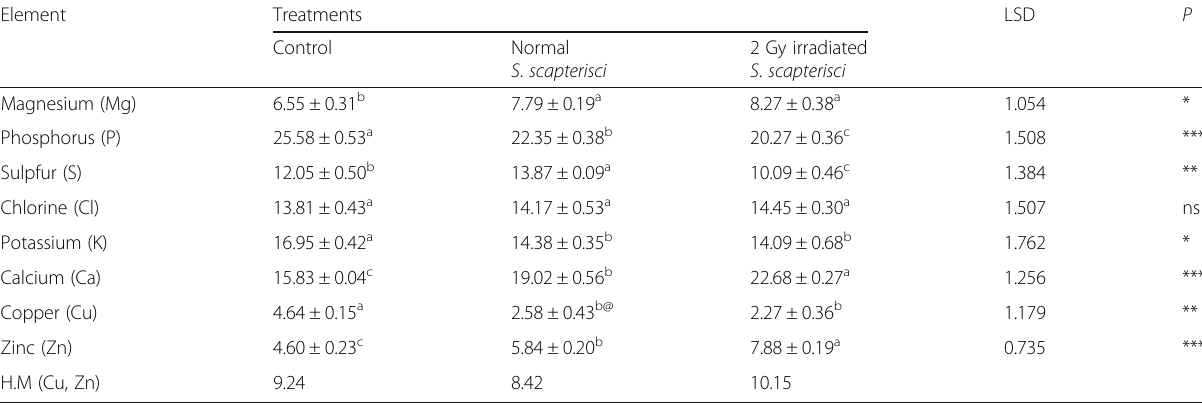
Table 4 Relative percentage of element composition in the whole body tissue of Culex pipiens larvae treated with normal and 2 Gy gamma irradiated Steinernema scapterisci Element Treatments Control Normal S .